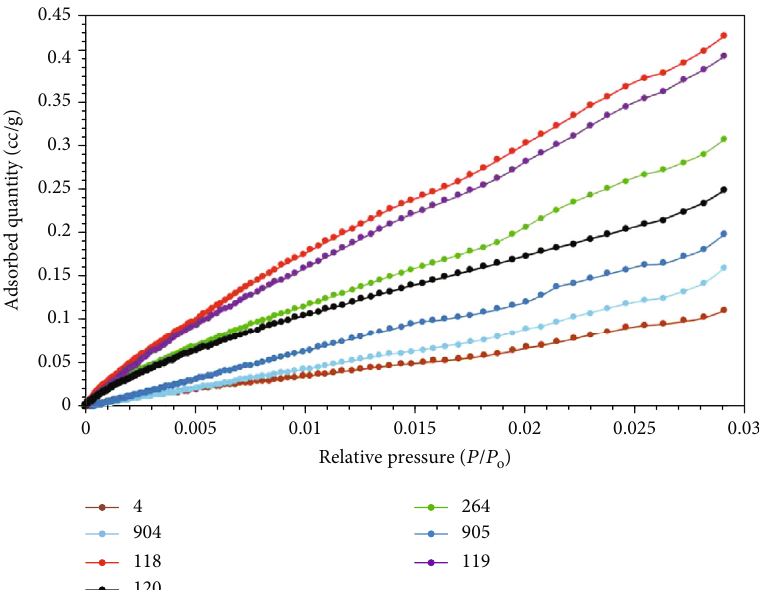
Figure 4: CO adsorption isotherms for the seven samples. 2